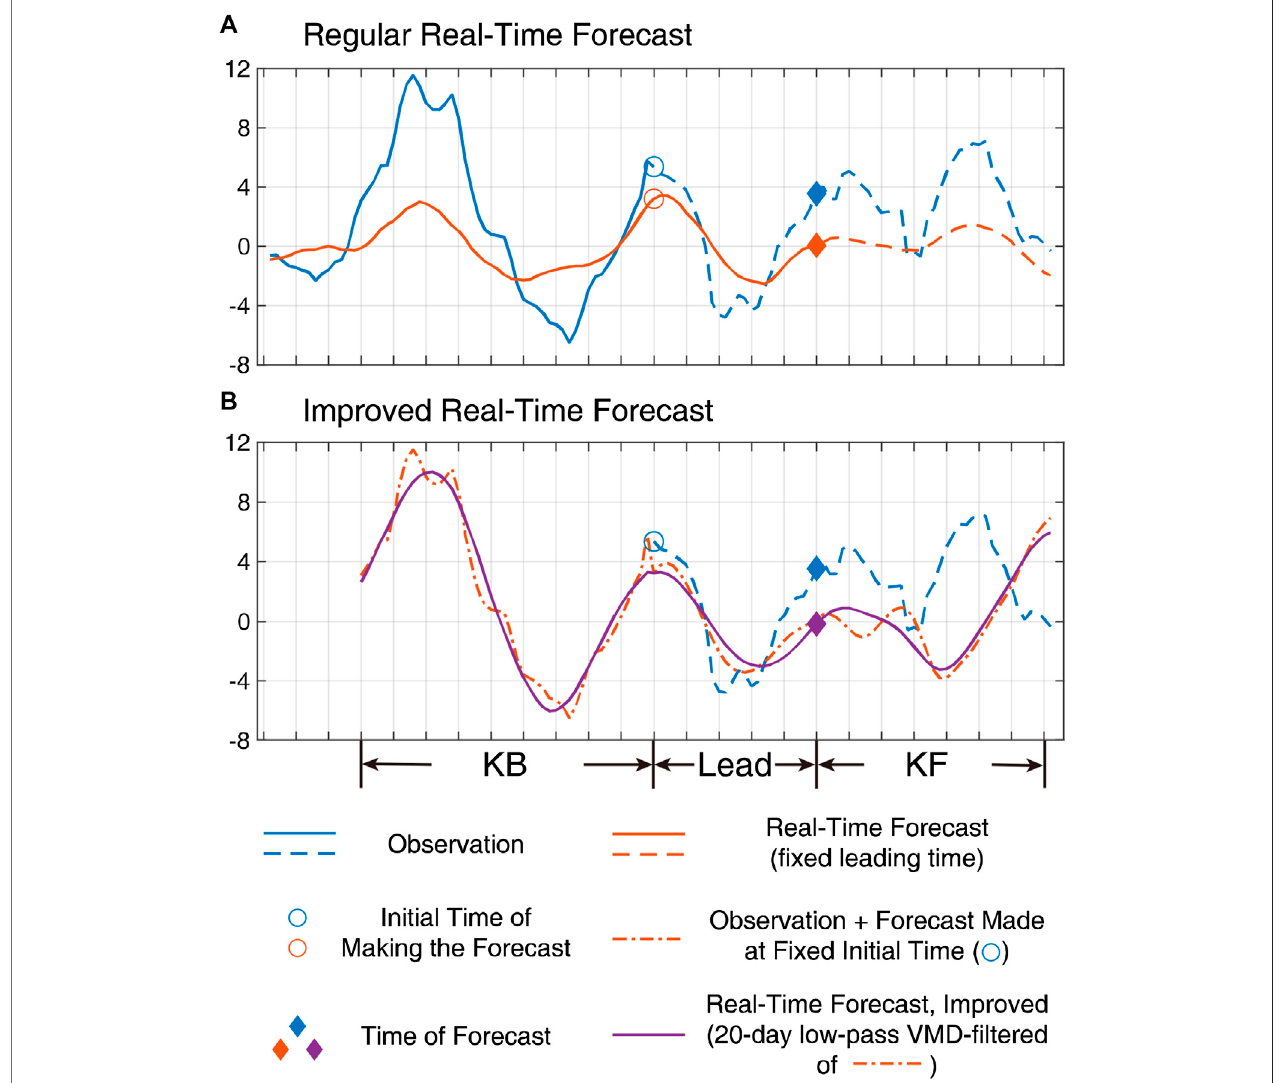
FIGURE 6 | An example for regular (A) and improved (B) real-time forecast. The blue lines represent the observational anomalies, and the orange lines in (A) representthehistoricalforecastanomaliesmadeata fi xedleadtimeforeachpoint.Thedashedcurvesindicatetheunknownpartsattheinitialtimeofmakingtheforecast (denoted by circles). The dash-dotted line in (B) indicates the forecast anomalies of different lead times made at the same initial point, linked with the observational anomalies before that point. The purple line in (B) is the 20-day low-pass VMD- fi ltered result of the dash-dotted line and is used to improve the estimation of the intraseasonal phase at the time of forecast (denoted by diamond